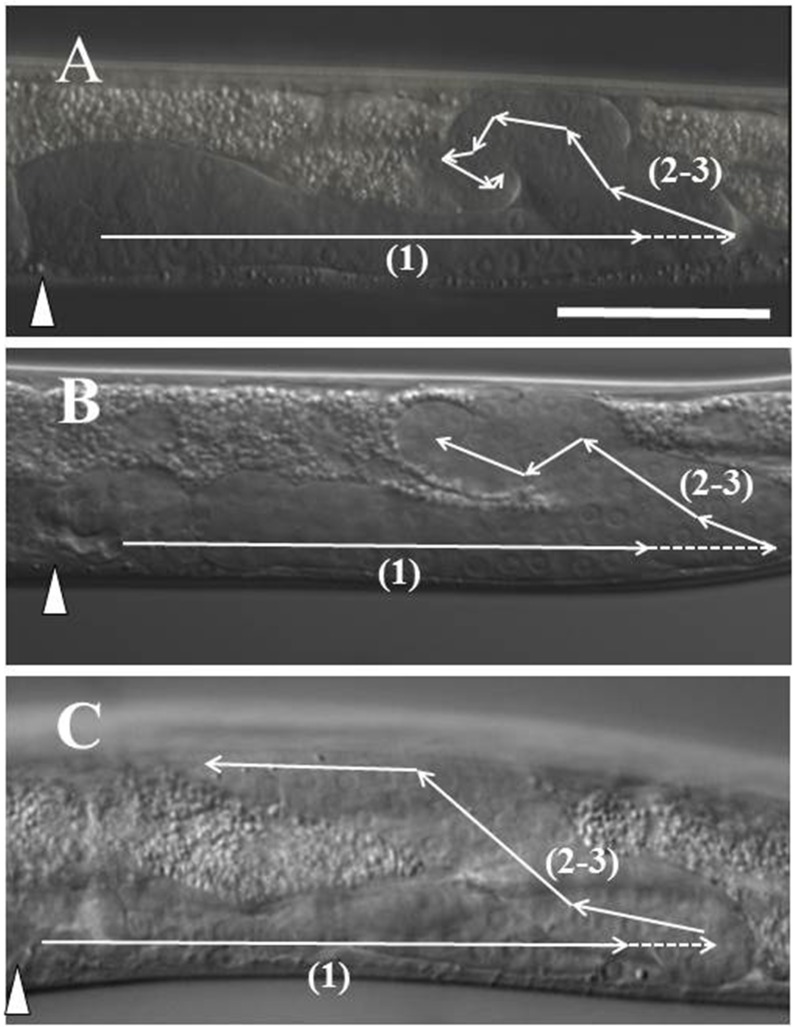
Common posterior gonad arm phenotypes of the GnT1/Mgat1 triple null mutant.(A-C) Diagram iv errors of Fig 2are of various trajectories in ngat-1 and the GnT1 triple mutants following normal phase 1 navigation, three of which are shown here by D.I.C. microscopy. In these, following a normal phase 1, the posterior DTC changes direction often and seemingly randomly, but rarely away from mid-body, although the distal arm in these cases does not return to the mid-body region. Panel C shows a posterior gonad arm like that of diagram ii. The return toward mid-body on the ventral side is usually shorter in the GnT1 triple compared to the ngat-1(ev821) mutant. Premature phase 1 ventral-to-dorsal migrations were observed for 7 anterior DTCs of 130 GnT1 triple mutant animals examined. Scale bar in panel A (for A-C) is 50 μm.